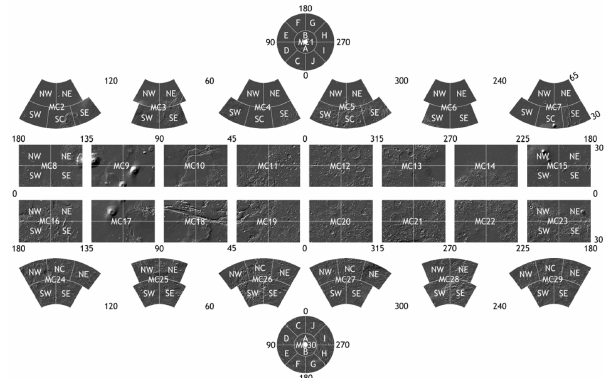
Figure 1: The Martian surface devided into 30 or 140 quadrangles (Dumke et al., 2010)